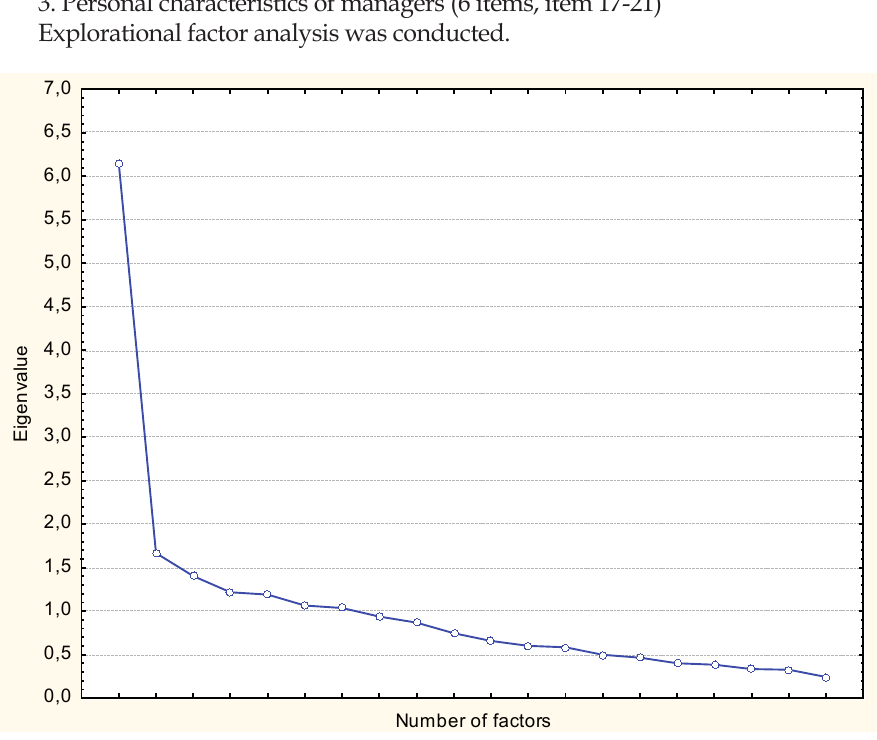
Graph 1: Eigenvalue of gender stereotypes